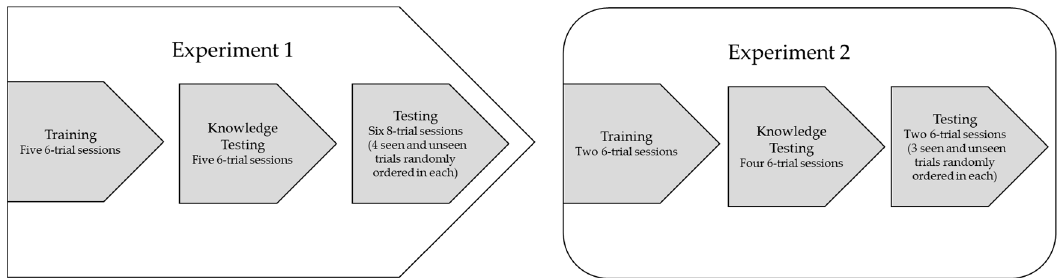
Figure 2. The flow of the experiments. Each phase lasted 2 – 3 weeks.